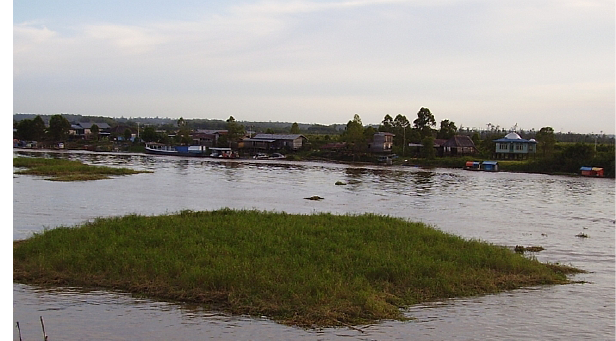
Fig. 13. Bulks of floating vegetation flushed off Lake Jempang, drifting downstream during a lake emptying